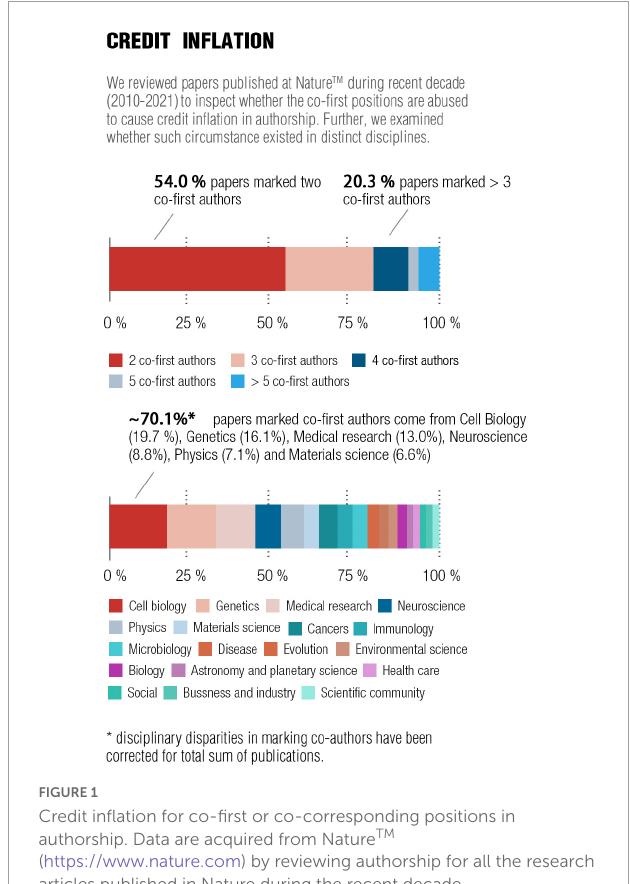
FIGURE1 Credit inflation for co-first or co-corresponding positions in authorship. Data are acquired from Nature TM (https://www.nature.com) by reviewing authorship for all the research articles published in Nature during the recent